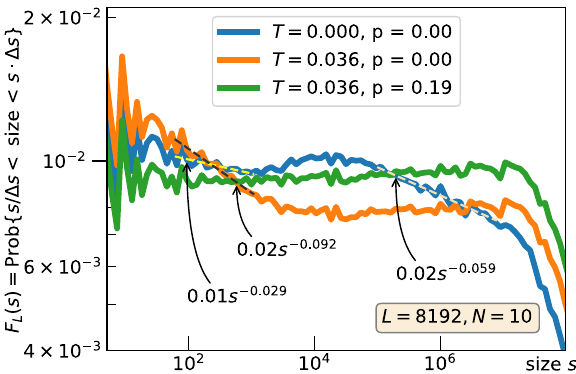
Figure 2. Size-frequency relation: adjustment of parameters. A part of F L ( s ) computed with the parameters 1 − τ reported in the legend and s -fits.